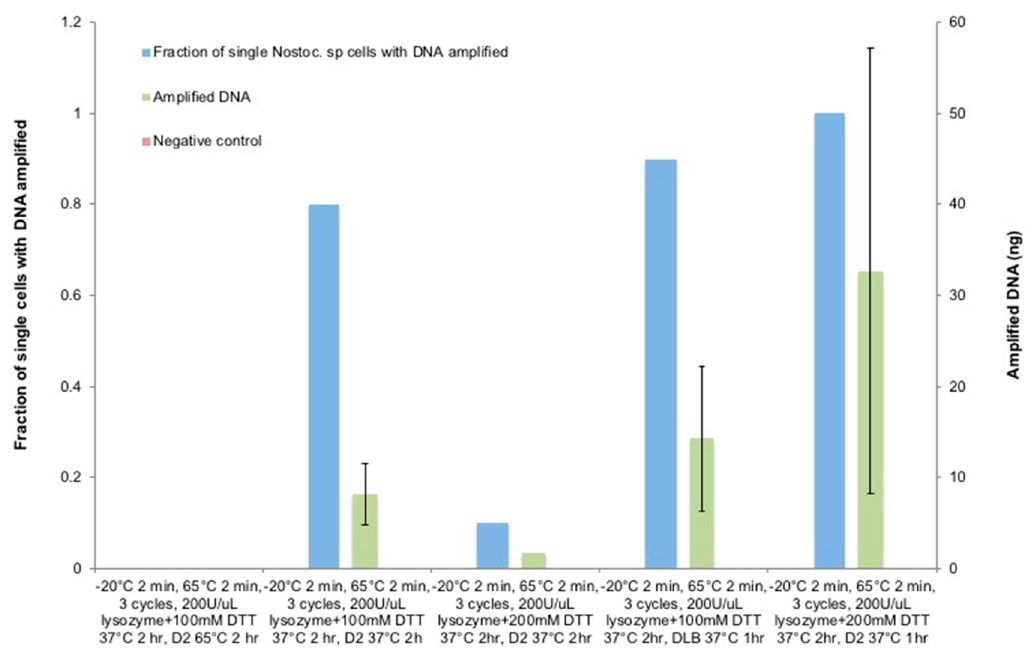
Figure 8. The DTT effect on Nostoc sp. lysis for SC-WGA. After the heat-shock treatment, a mixture of 0.5 mM of EDTA, 200 U/µL of Ready-Lyse lysozyme, and the DTT of different concentrations was added to the cells and incubated at 37 °C for 2 h, followed by adding a D2 alkaline lysis buffer. N = 10 single cells per condition; error bars represent standard deviation.